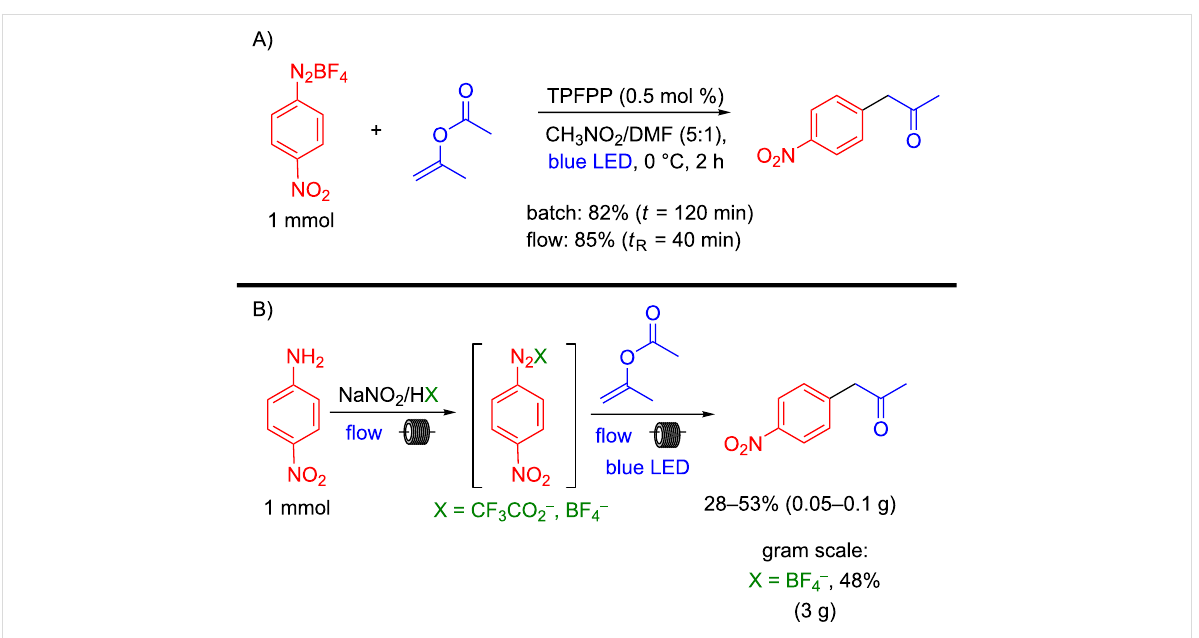
Scheme 5: Photoarylation of isopropenyl acetate A) Comparison between batch and continuous-flow approaches and B) end-to-end